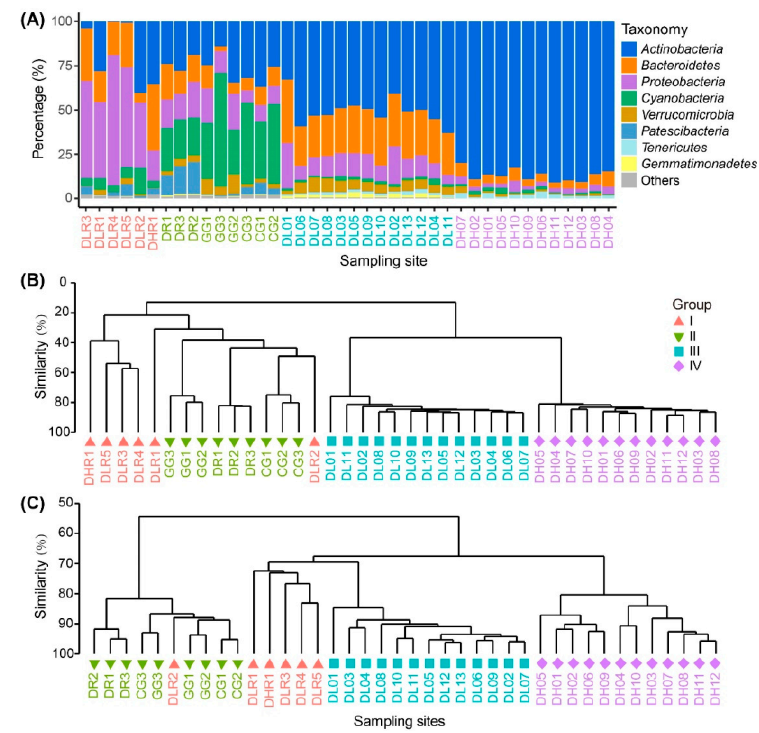
Figure 3. Taxonomic composition, bacterial community composition (BCC) and predicted bacterial functional composition (BFC) among the four habitat groups based on salinity gradients and ecosys- tem types. ( A ) Taxonomy of the bacteria at the phylum level. ( B ) Cluster analysis dendrogram of the BCC. ( C ) Cluster analysis dendrogram of predicted BFC. Samples are those from freshwater rivers (Group I), freshwater lakes (Group II), low-brackish Lake Dalinor (Group III), and high-brackish Lake Daihai (Group